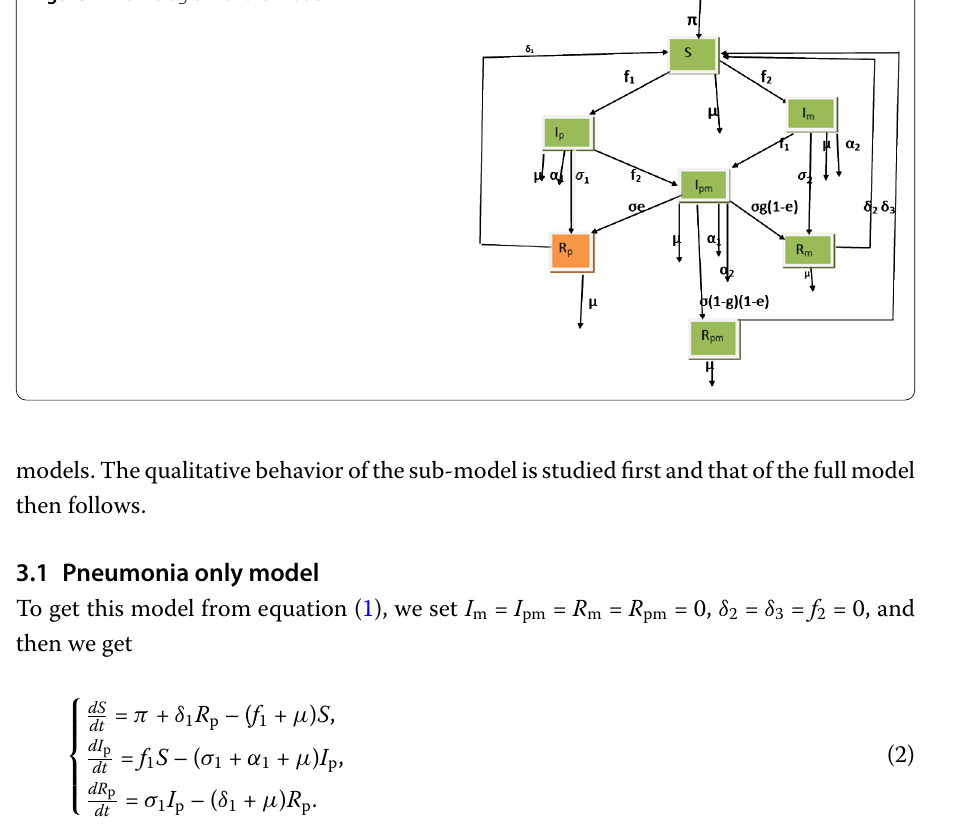
Figure 1 Flow diagram of the